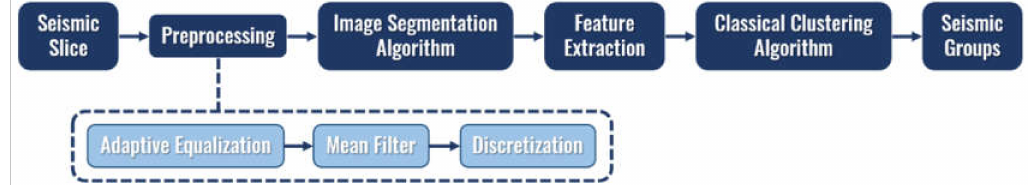
Figure 3. Image Preprocessing Pipeline.